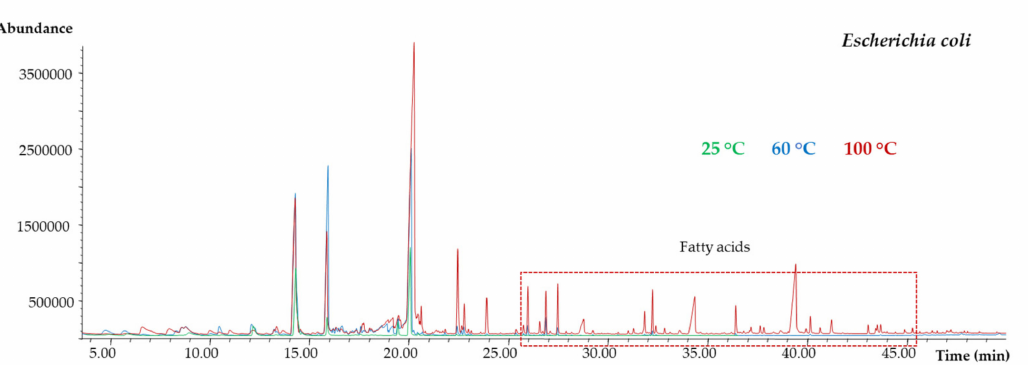
Figure 4. Comparison between the chromatographic abundance performing SPME at three di ff erent